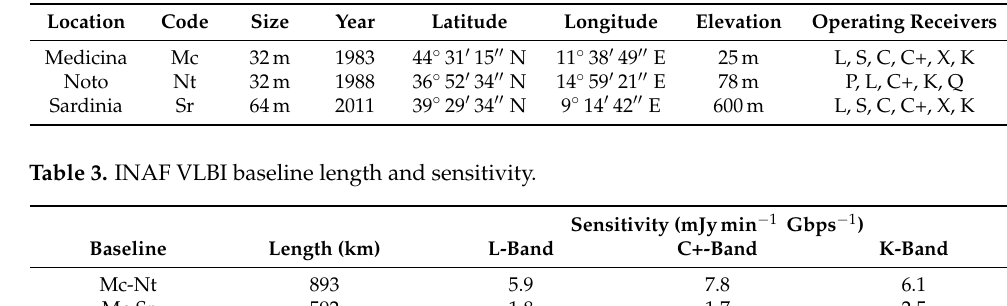
Figure 2. The location of the three INAF radio telescopes. From North to South: Medicina, Sardinia, and Noto. Table 2. INAF radio telescopes.